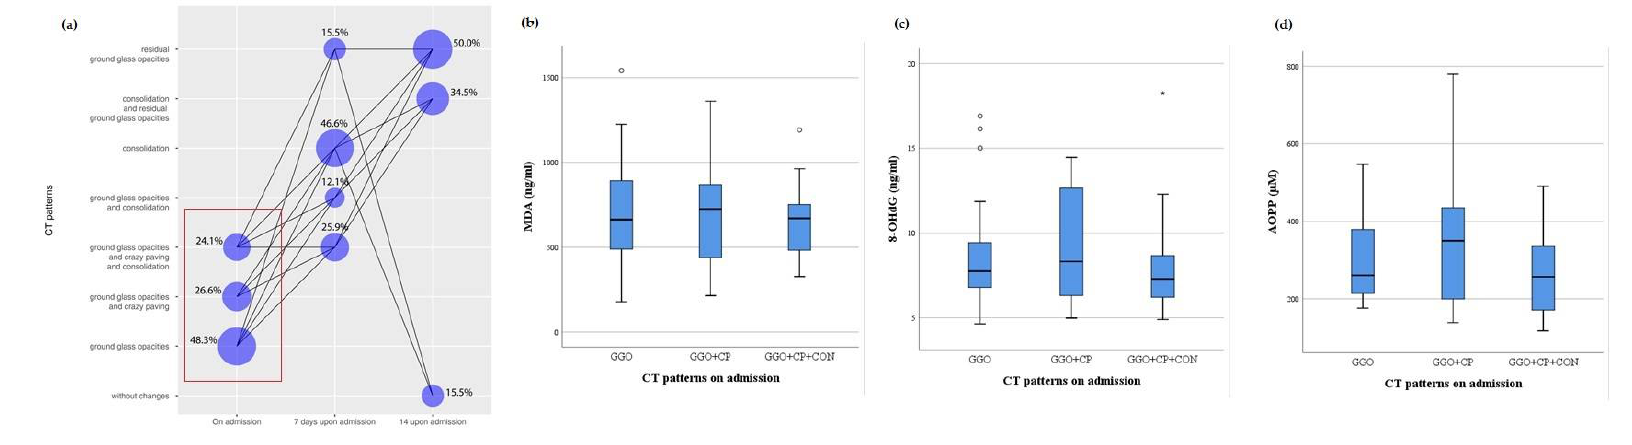
Figure 2. The frequency of CT patterns with their timely progression ( a ) and relation with the levels MDA ( b ), 8-OHdG ( c ), and AOPP ( d ) in COVID-19 patients on admission.; GGO-Ground Glass Opacities; CP-Crazy Paving; CON-Consolidation.